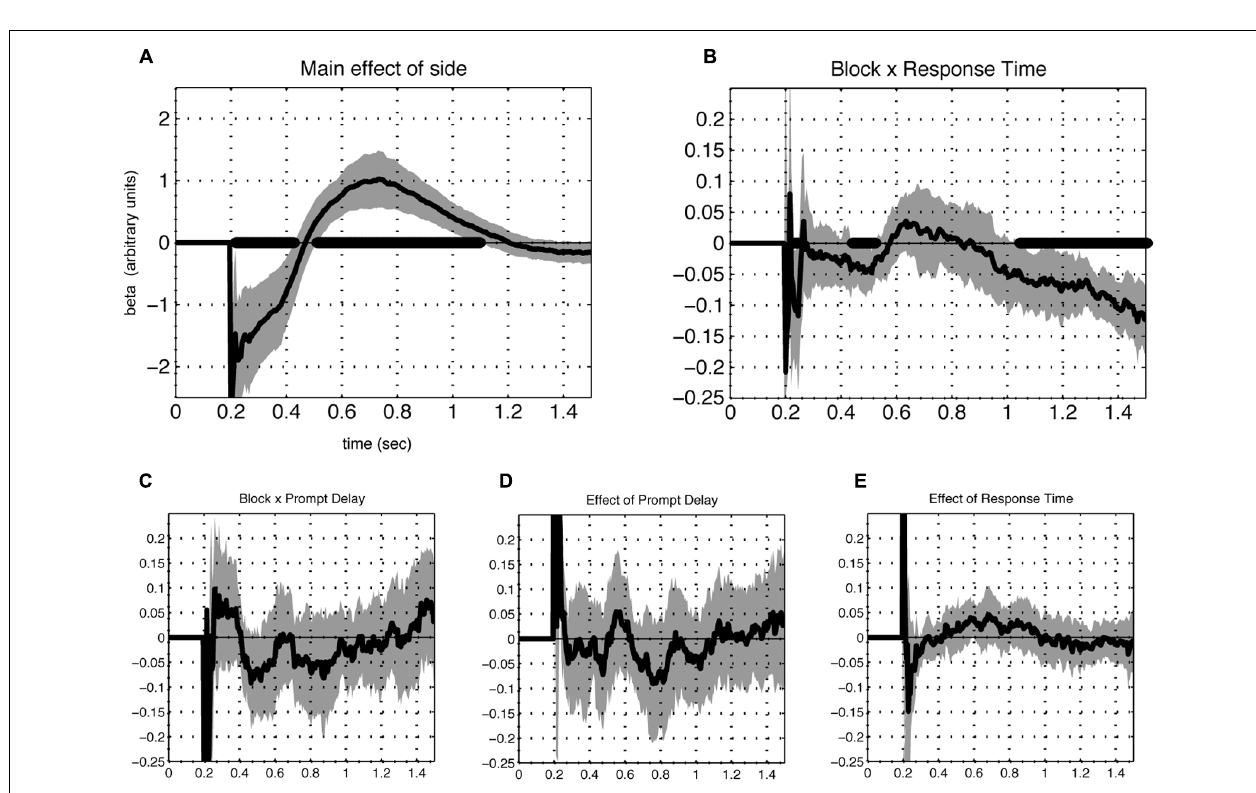
FIGURE 4 | Effects of preference rating (magenta) and block (cyan) terms on gaze direction as modeled in the GLM with respect to stimulus onset ( t = 0). Left Panel: Average beta values ± 2 SEM over time for each term ( N = 23). Right Panel: Paired contrasts between time points for the preference rating term (R, above the diagonal) and the block term (B, below the diagonal). Color scale shows